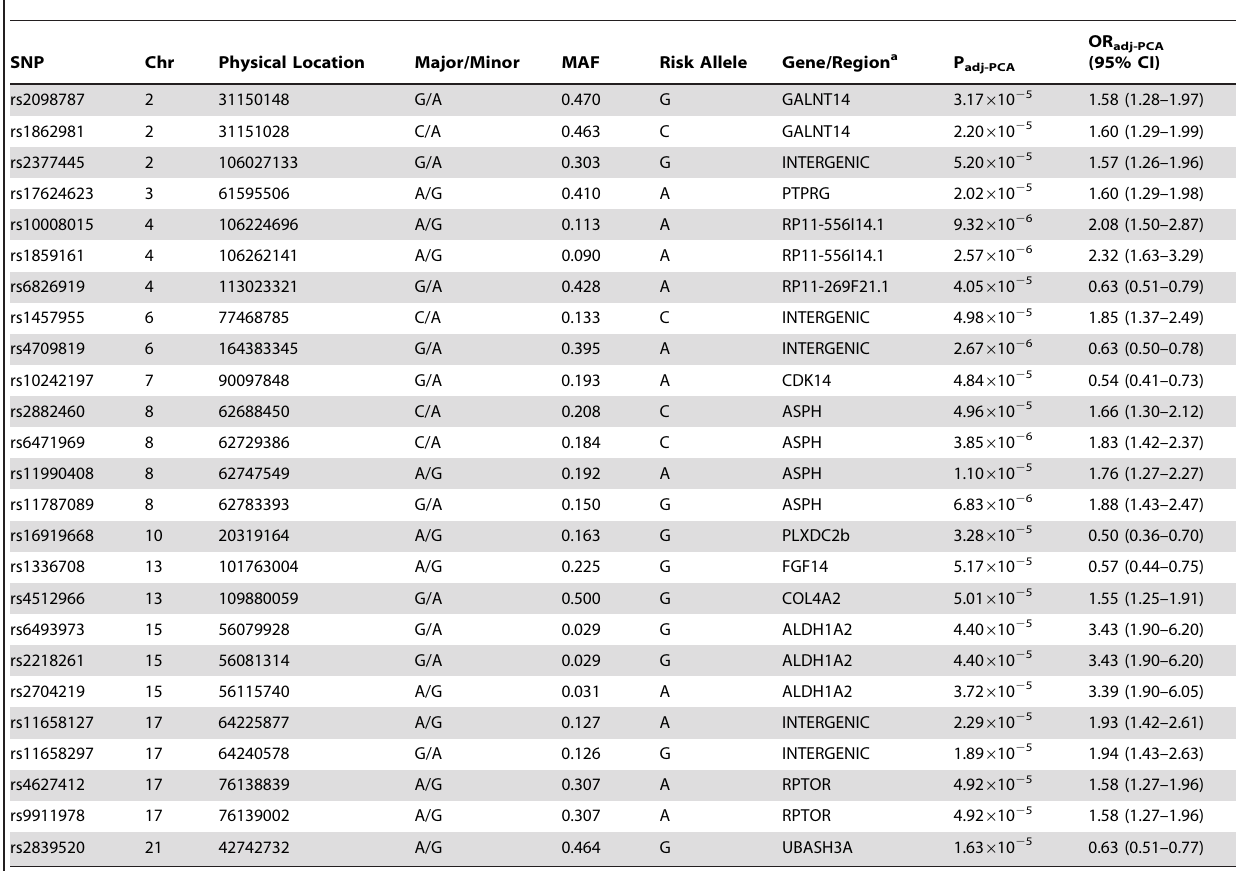
Table 4. Top 25 genotyped polymorphisms, adjusted for the first two PCs, ordered by chromosome and physical location, from the GWAS analysis for the subset of Raine Study participants for whom full covariate data (day care attendance, allergy and non- exclusive breast feeding) were